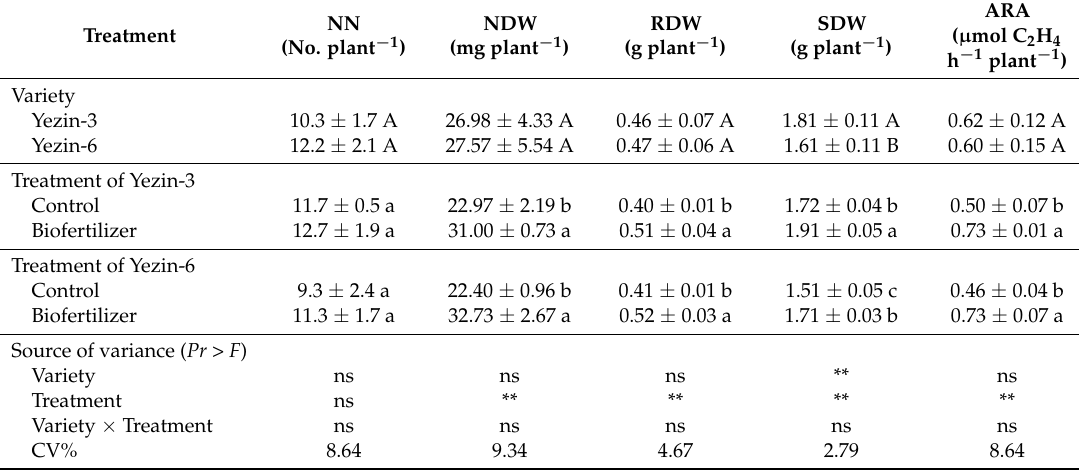
Table 4. Effect of biofertilizer on plant growth, nodulation and nitrogen fixation in terms of ARA of Yezin-3 and Yezin-6 soybean varieties at V6